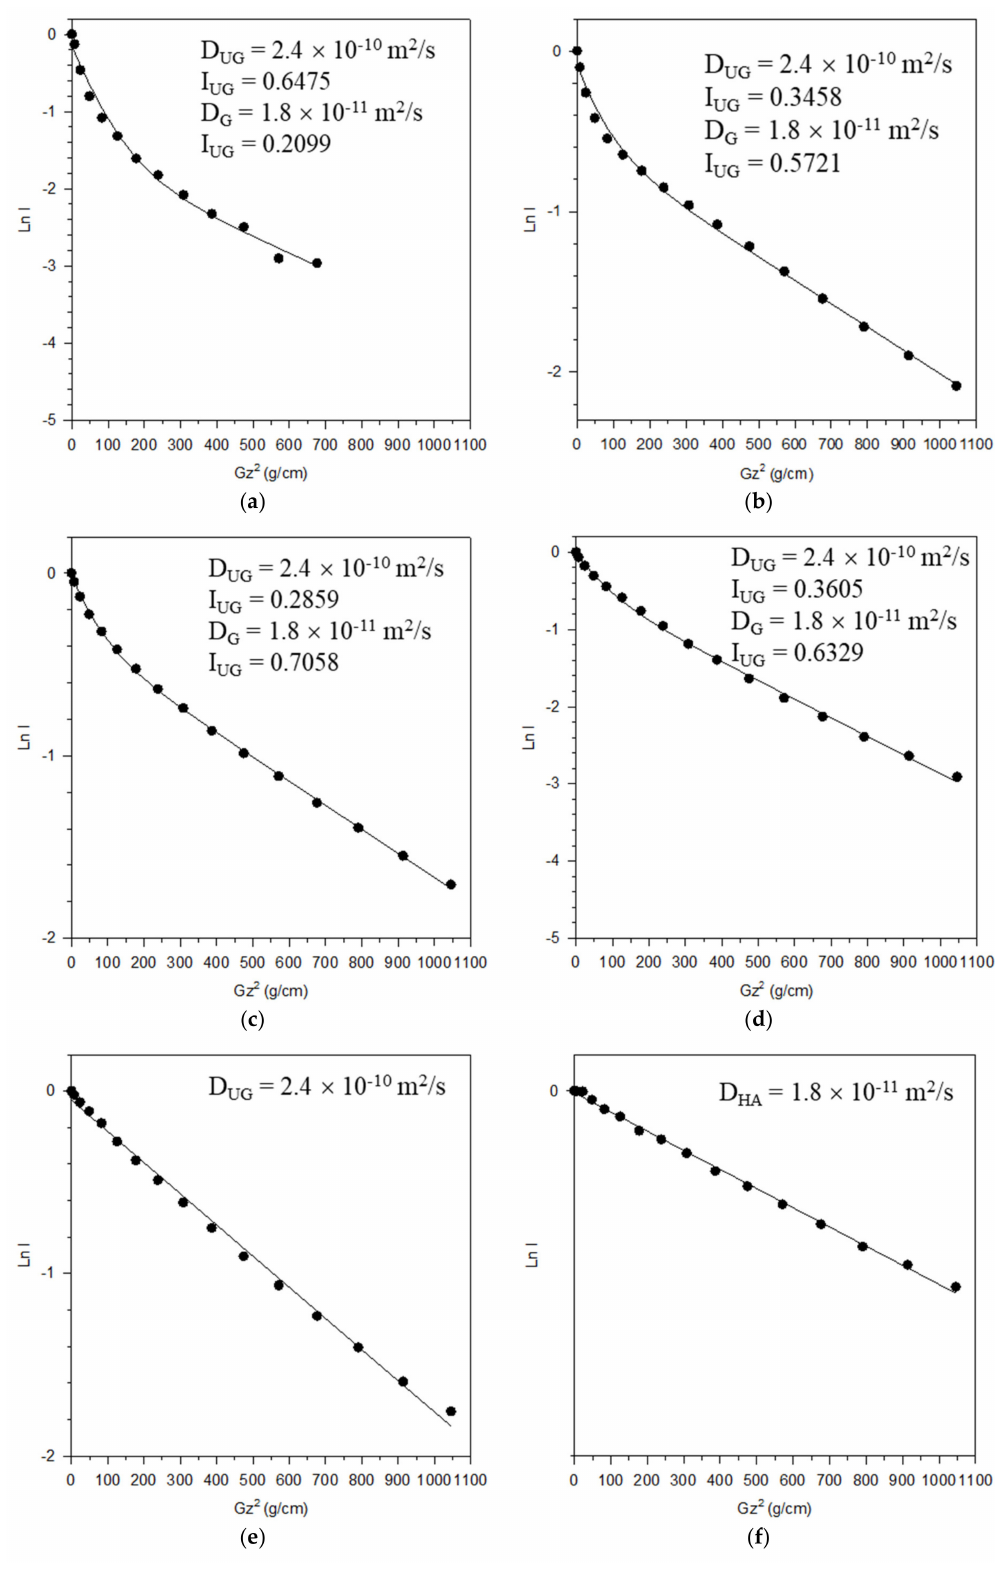
Figure 4. Diffusion curves and diffusion coefficients extracted from DOSY spectra (ref